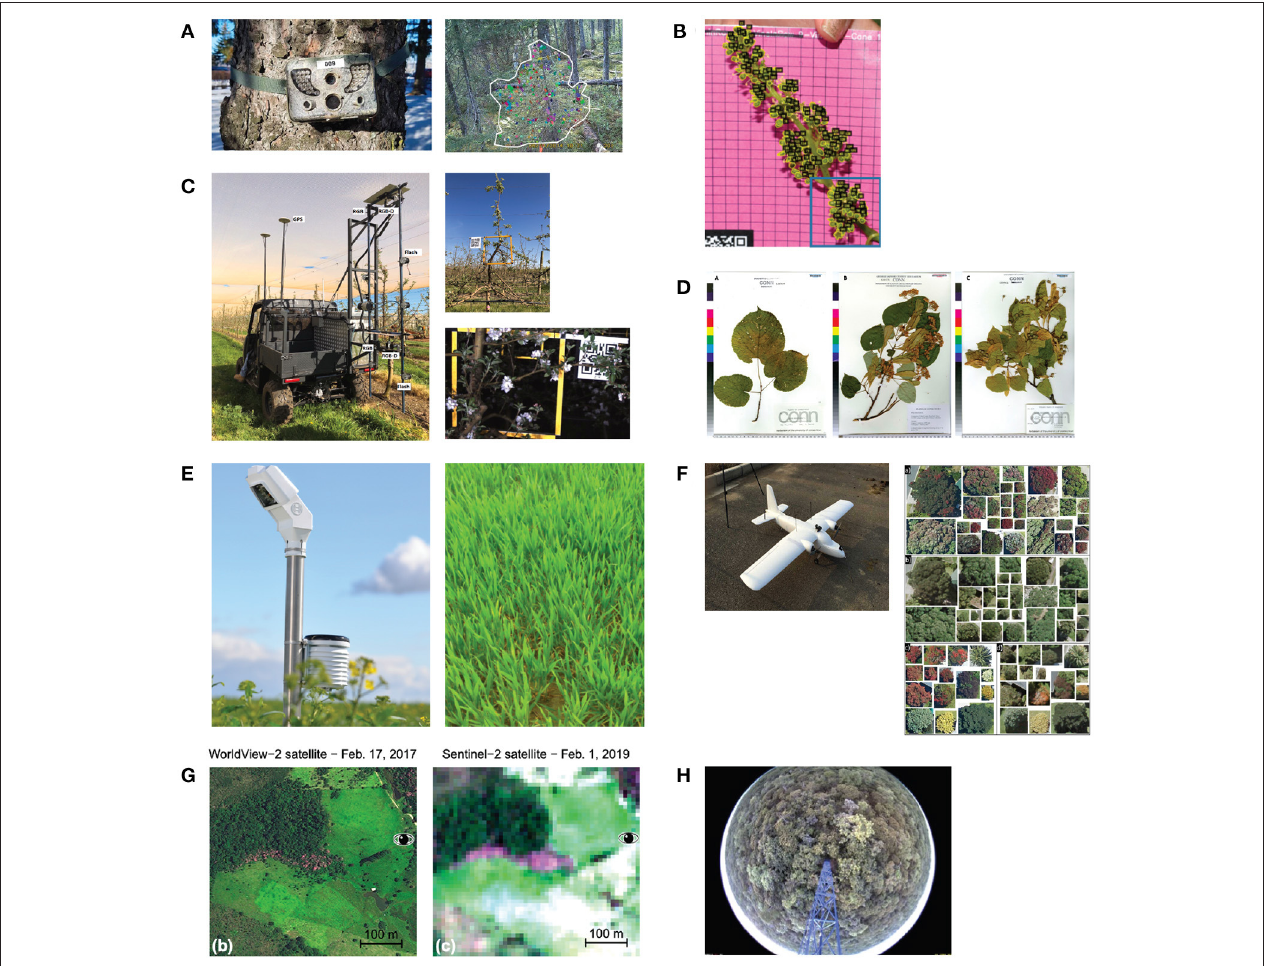
FIGURE 6 | Examples of image capturing methods. (A) A wildlife camera was used to capture images for budburst classification in coniferous forests (Correia et al., 2020). (B) Images were taken manually on a plain background (Pahalawatta et al., 2020). (C) Images of apple flowers were collected by a mobile platform (Wang et al., 2020 ). (D) Digitalized herbarium specimens (Lorieul et al., 2019). (E) Close-up shots of certain areas of agriculture were taken automatically (Yalcin, 2017). (F) Aerial images were taken by high resolution UAVs imagery ( Pearse et al., 2021). (G) Sentinel-2 and Worldview-2 satellite images (Wagner, 2021). (H) Camera installed on an 18m tower using digital timestamps (Nogueira et al.,